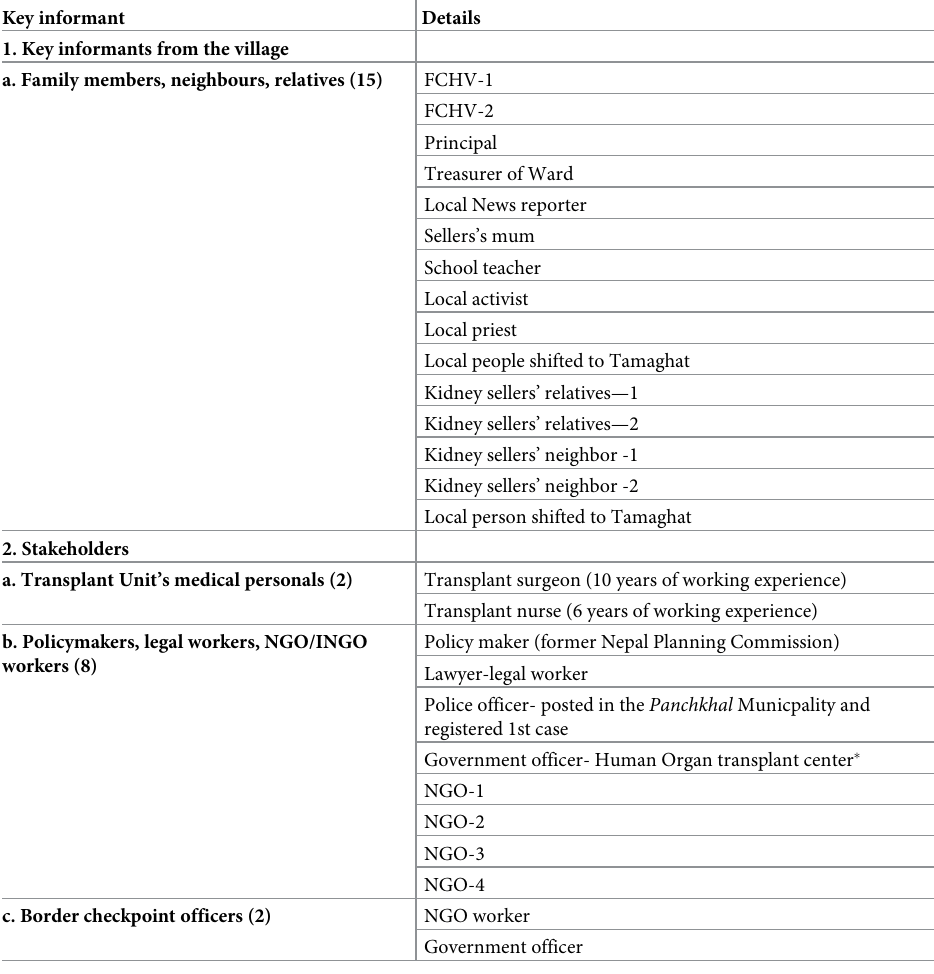
Table 3. General characteristics of Key